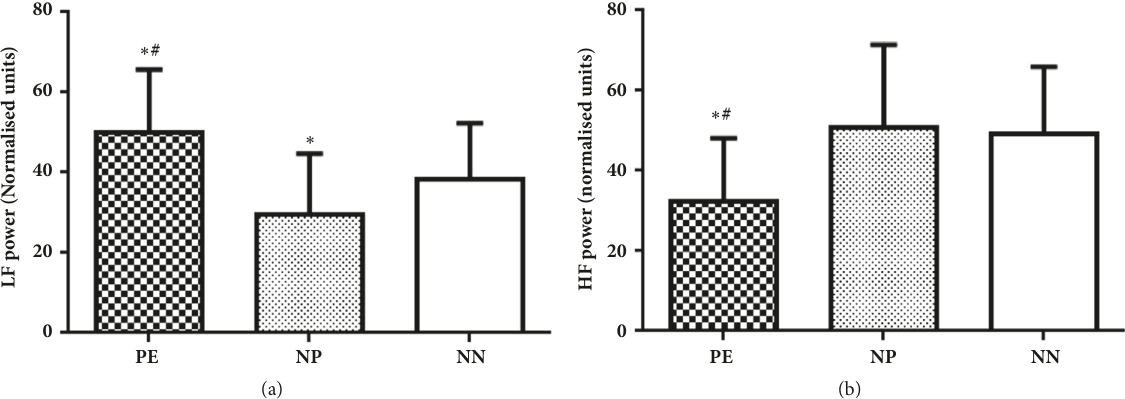
Figure 4: Comparison of spectral components of heart rate variability in normalised units in 3 groups of subjects; PE, preeclampsia; NP, normotensive pregnant; NN, normal nonpregnant. (a) LF, low frequency power and (b) HF, high frequency power. Values are mean ± SD (n=40). ∗ p < 0.05 versus normal nonpregnant females; # p < 0.05 versus normotensive pregnant